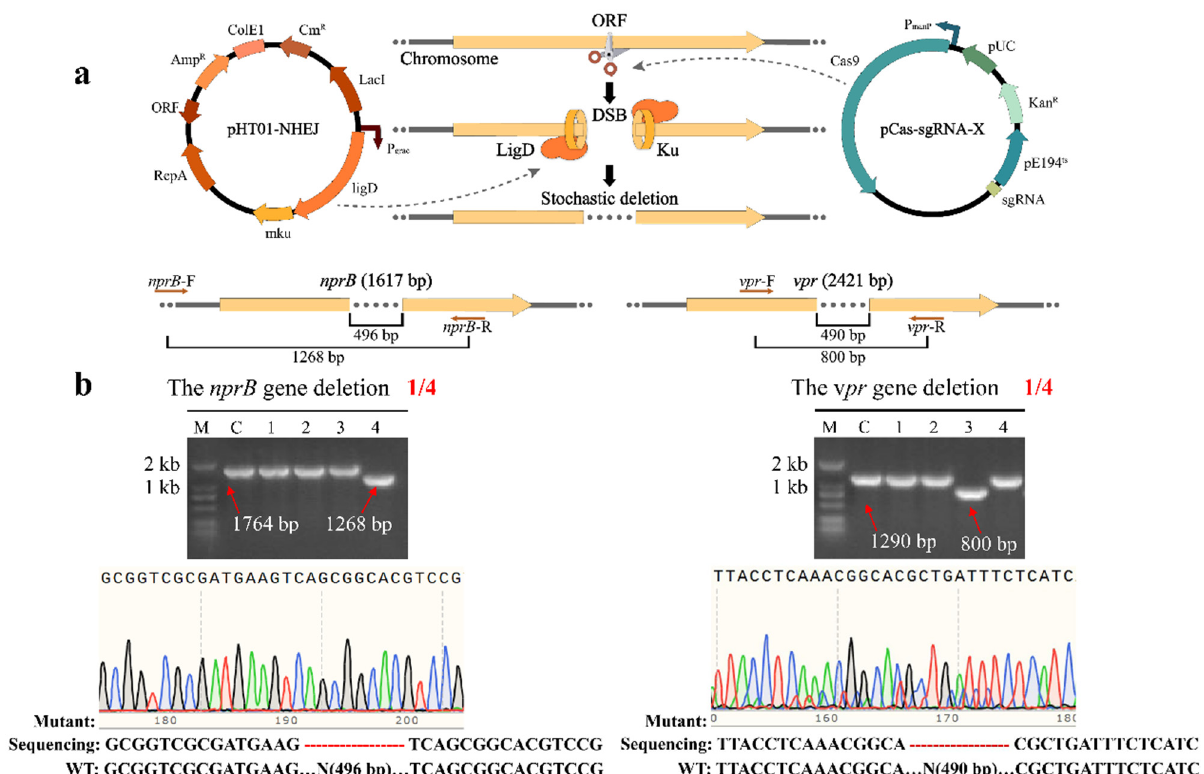
Figure 1. Repair of DNA double-strand breaks by the NHEJ system. ( a ) Deletion of extracellular protease genes in B. subtilis using CRISPR-Cas9-assisted non-homologous end-joining editing. ( b ) PCR verification of the vpr and nprB gene deletions.